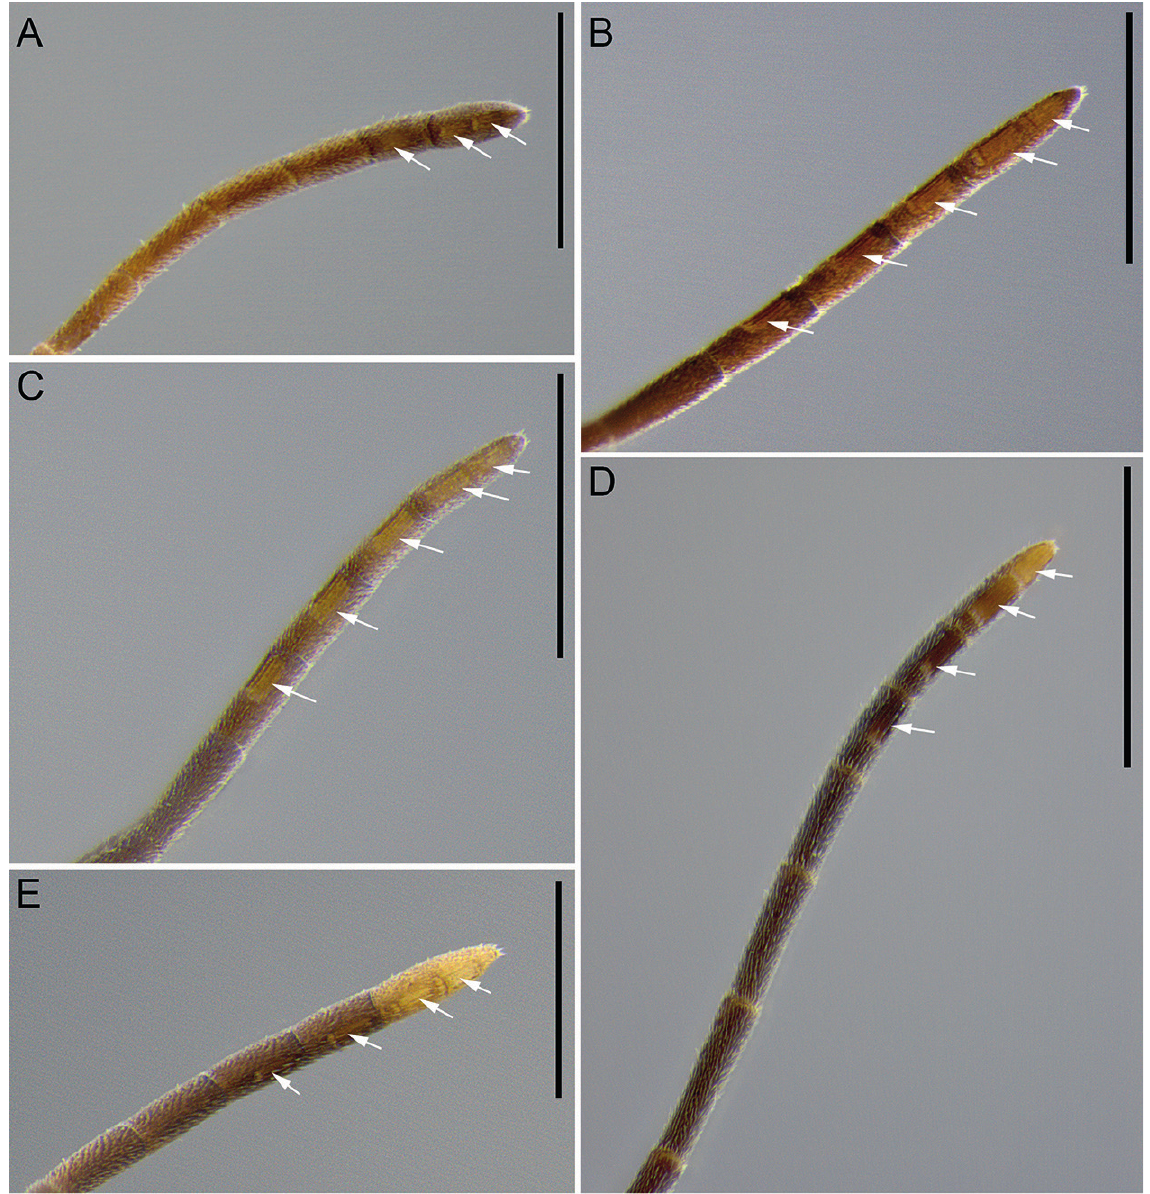
Fig. 1. Rhinaria in differents flagellomeres of the female in species of Pareucamptonyx Olmi, 1991. A . Rhinaria in flagellomeres 7–8 of P. albopictus Martins sp. nov. B . Rhinaria in flagellomeres 5–8